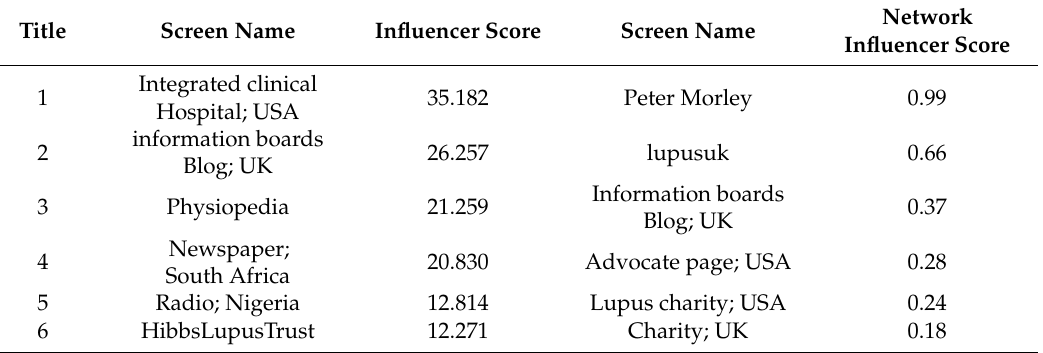
Table 1. Top scored